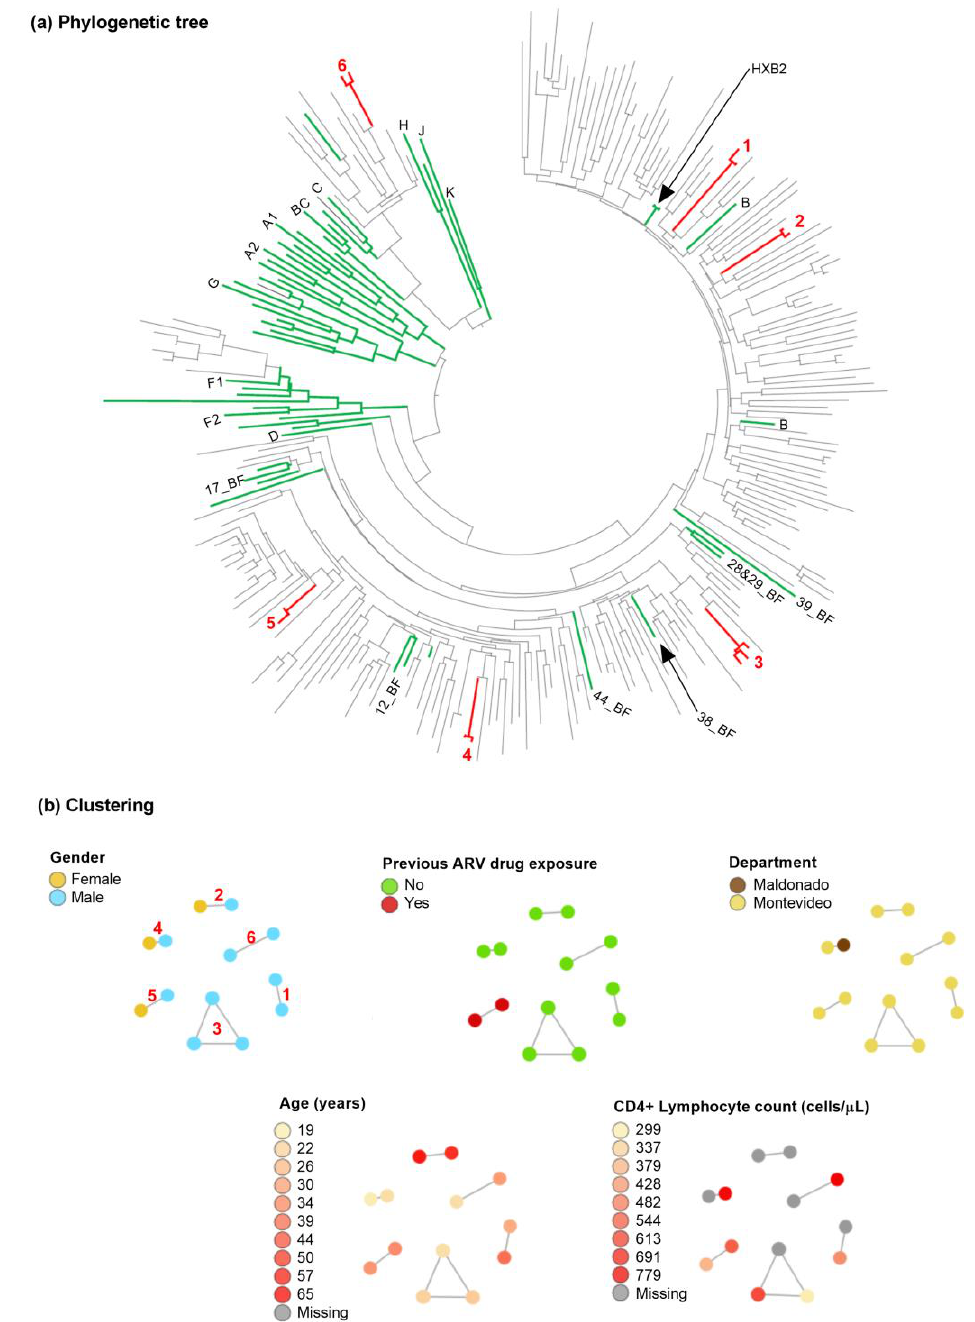
Figure 1. Phylogenetic tree and main clusters. ( a ) Phylogenetic tree. Sequences from 205 persons living with HIV participating in the HIV drug resistance survey in Uruguay were included with HIV-1 subtype references (green) obtained from Los Alamos HIV Database. Sequences were aligned with ClustalW. A maximum-likelihood tree was constructed with Mega v11, using the GTR + Г + I nucleotide substitution model with 1000 bootstrap repetitions. Possible clusters supported by bootstrap ≥ 99% are shown and numbed in the tree (red numbers 1–6). ( b ) Clustering. Putative transmission links were evaluated using HIVTRACE at a TN93 distance threshold of <1.5%. Only sequences in a cluster are shown. Nodes are coloured by different available attributes. The same clusters coloured in the tree are indicated in ( b ).